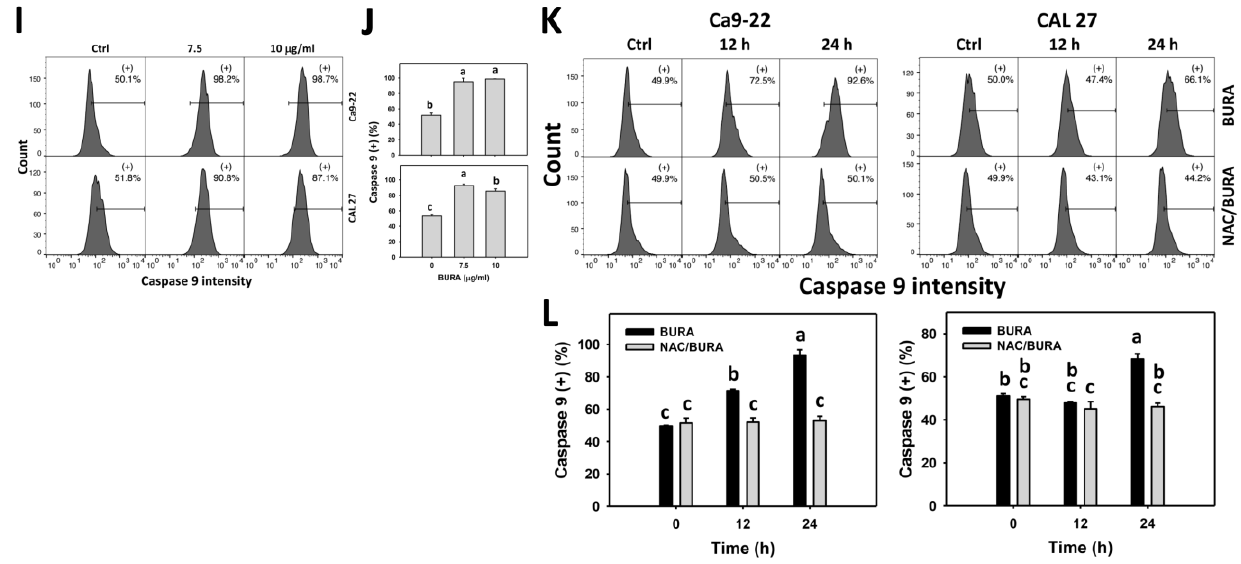
Figure 5. BURA causes caspase 3/8/9 activations in oral cancer cells. ( A , B , E , F , I , J ) Caspase 3/8/9 patterns and quantifica- tions. Oral cancer cells (Ca9- 22 and CAL 27) were treated with BURA (control (0.1% DMSO), 7.5 μg /mL (25.3 μM), and 10 μg /mL (33.8 μM), 24 h). (+) located within the patterns represent pancaspase (+). ( C , D , G , H , K , L ) NAC effect on Cas 3/8/9 patterns and quantifications. After NAC treatment (10 mM, 1 h), cells were treated with BURA (10 μg /mL) for 0 (control), 12 and 24 h. Data, mean ± SD ( n = 3). Data top-labeled with non-overlapping lower-case letters differ significantly according to multi-comparisons ( p < 0.05).